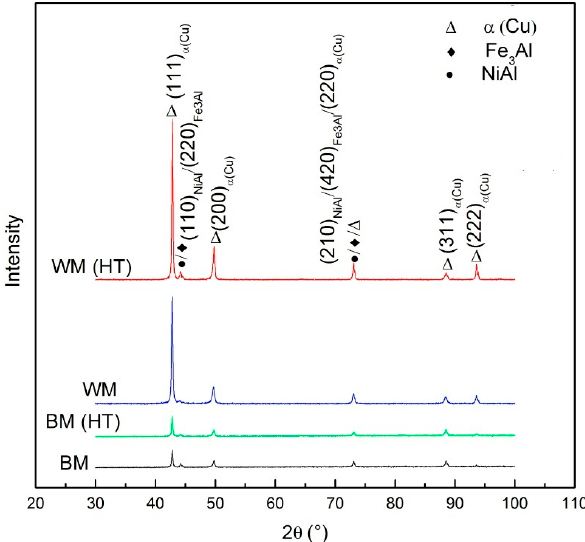
Figure 6. Comparison of phase constitutions of as-cast BM, as-deposited WM, heat-treated BM, and heat-treated WM.